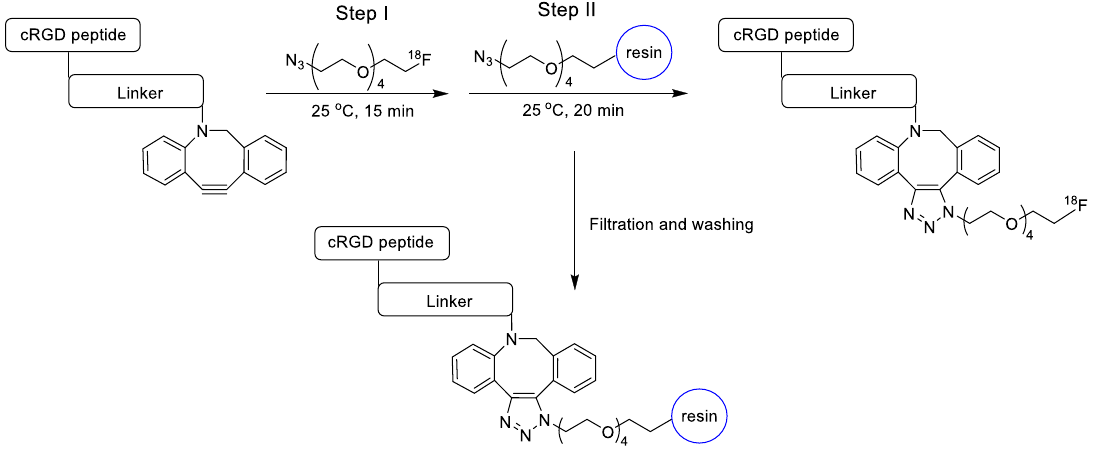
Figure 4. 18 F-radiolabeling of DBCO-modified cRGD dimer using 18 F-labeled azide precursor and polystyrene-supported azide-modified resin for purification of unreacted substrate.